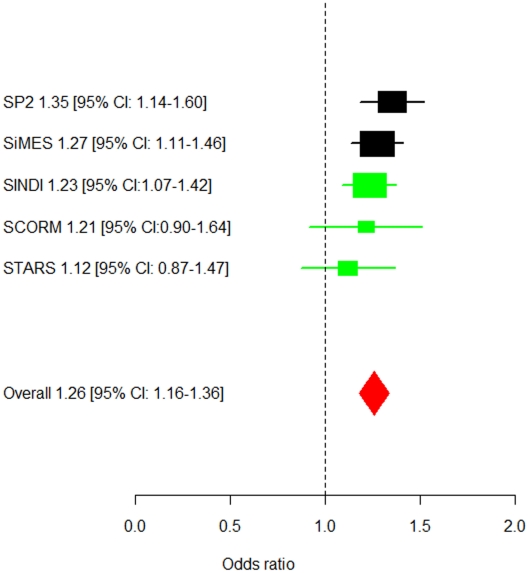
Forest plot of the estimated allelic odds ratios for the lead SNP rs7677751.The allelic odd ratios for allele T of rs7677751 and 95% confidence intervals are presented for the five studies separately (black rectangles for discovery studies, green rectangles for replication studies), the meta-analyses during the discovery (black diamond) and replication (green diamond) phases, and for the overall meta-analysis across all five studies (red diamond).